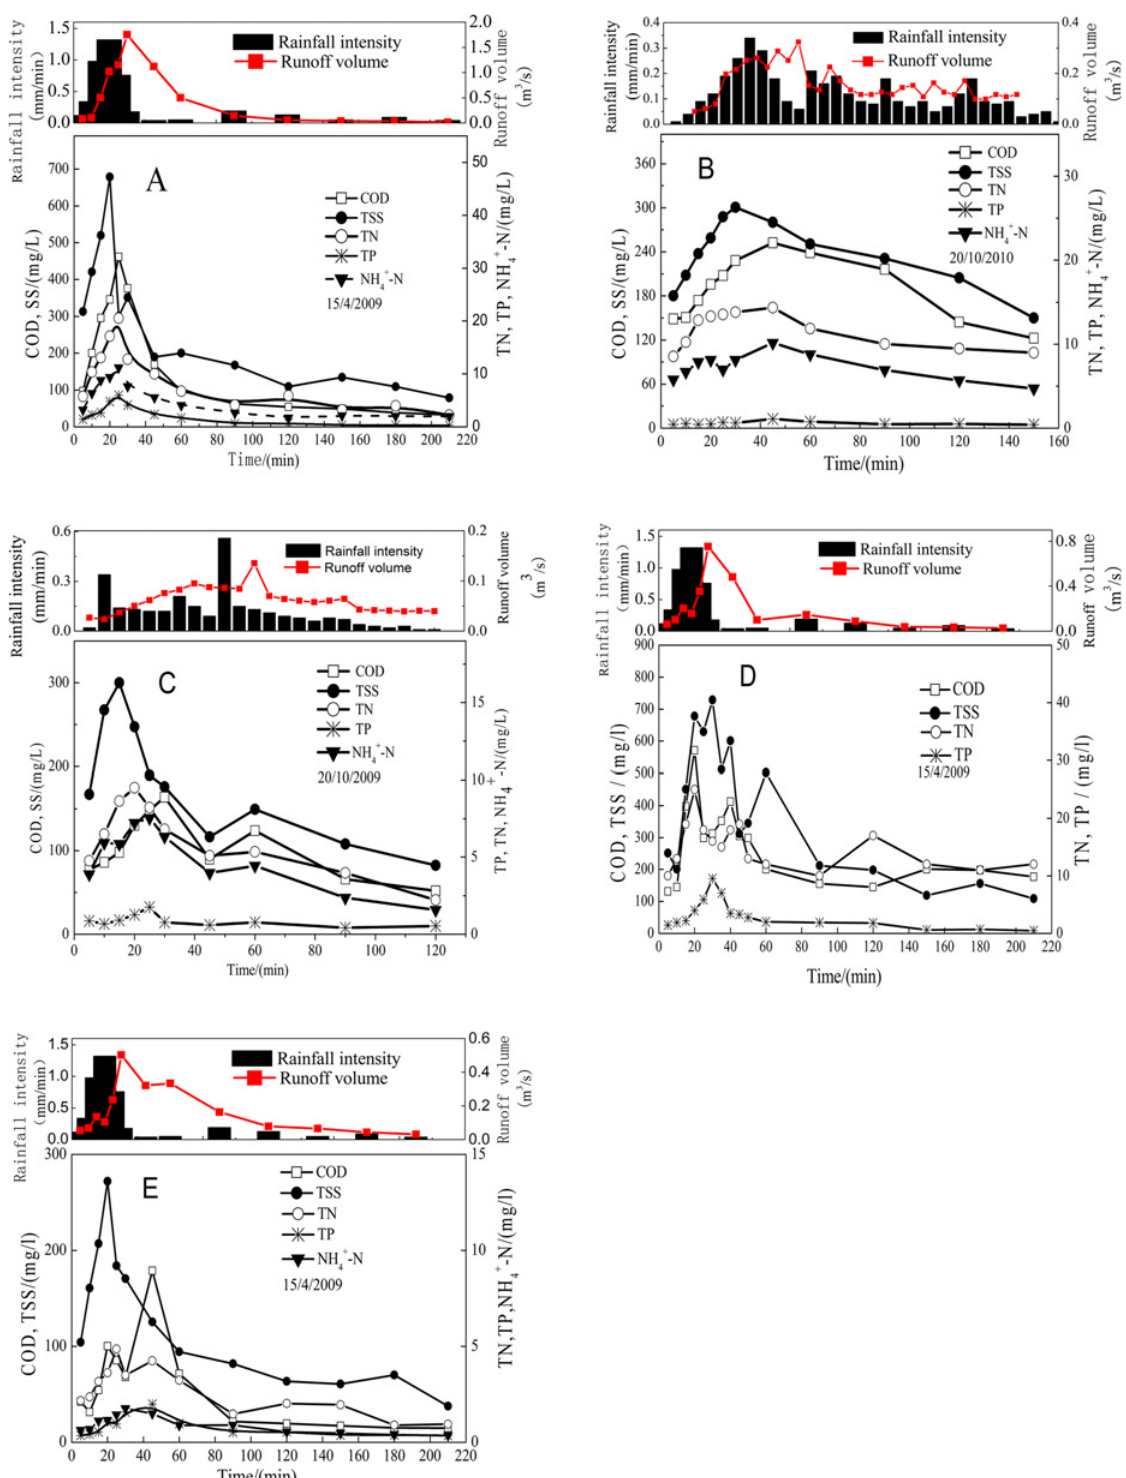
Fig 2. Pollutant wash-off process curves in NS , DLS and TS .